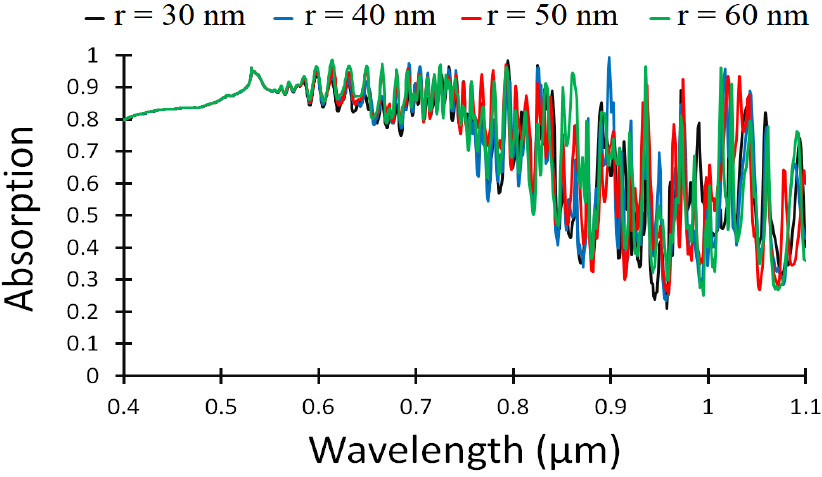
Figure 8. Light absorption (%) as a function of wavelength for different NP radii.